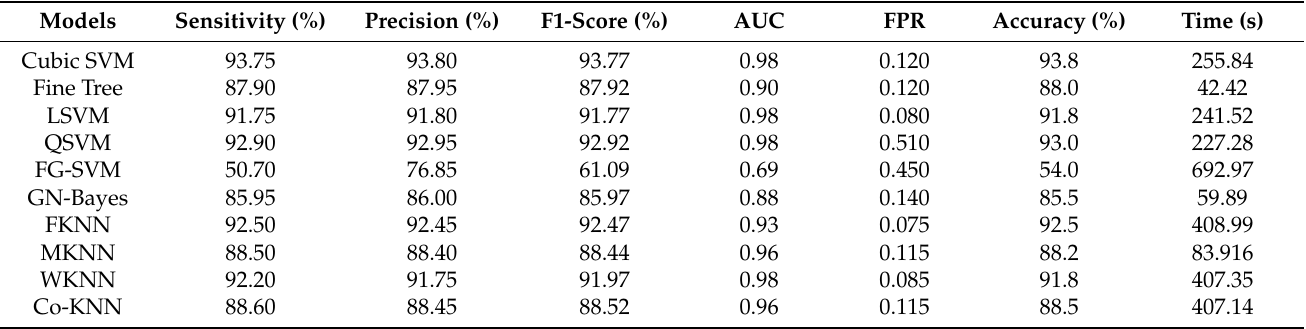
Table 7. Classification results using MEWOA on fusion deep features for CBIS-DDSM.